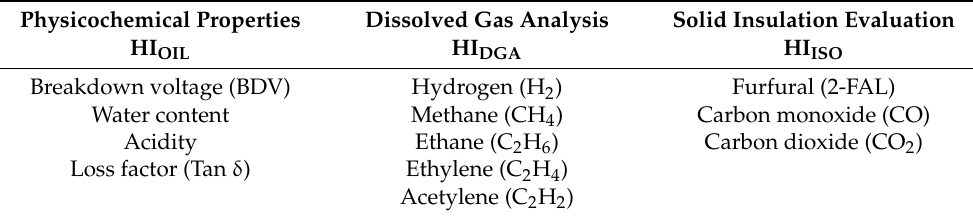
Table 1. The diagnostic parameters included in the presented health index with the division into respective